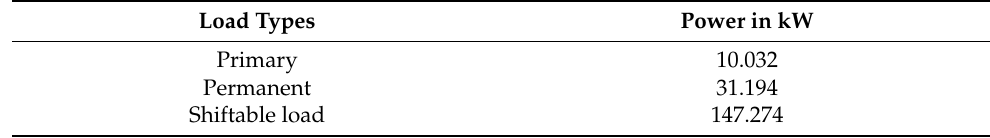
Table 2. Power consumption of the primary, permanent, and shiftable